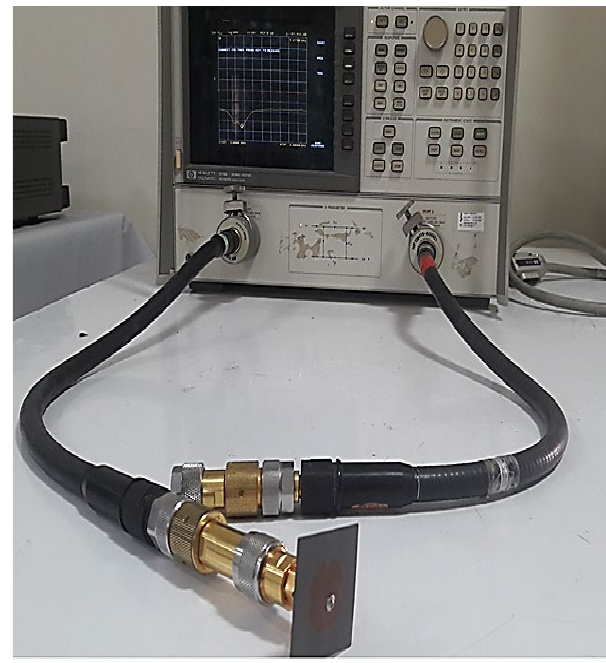
Fig. 14. An antenna connected to one port and matched load with other